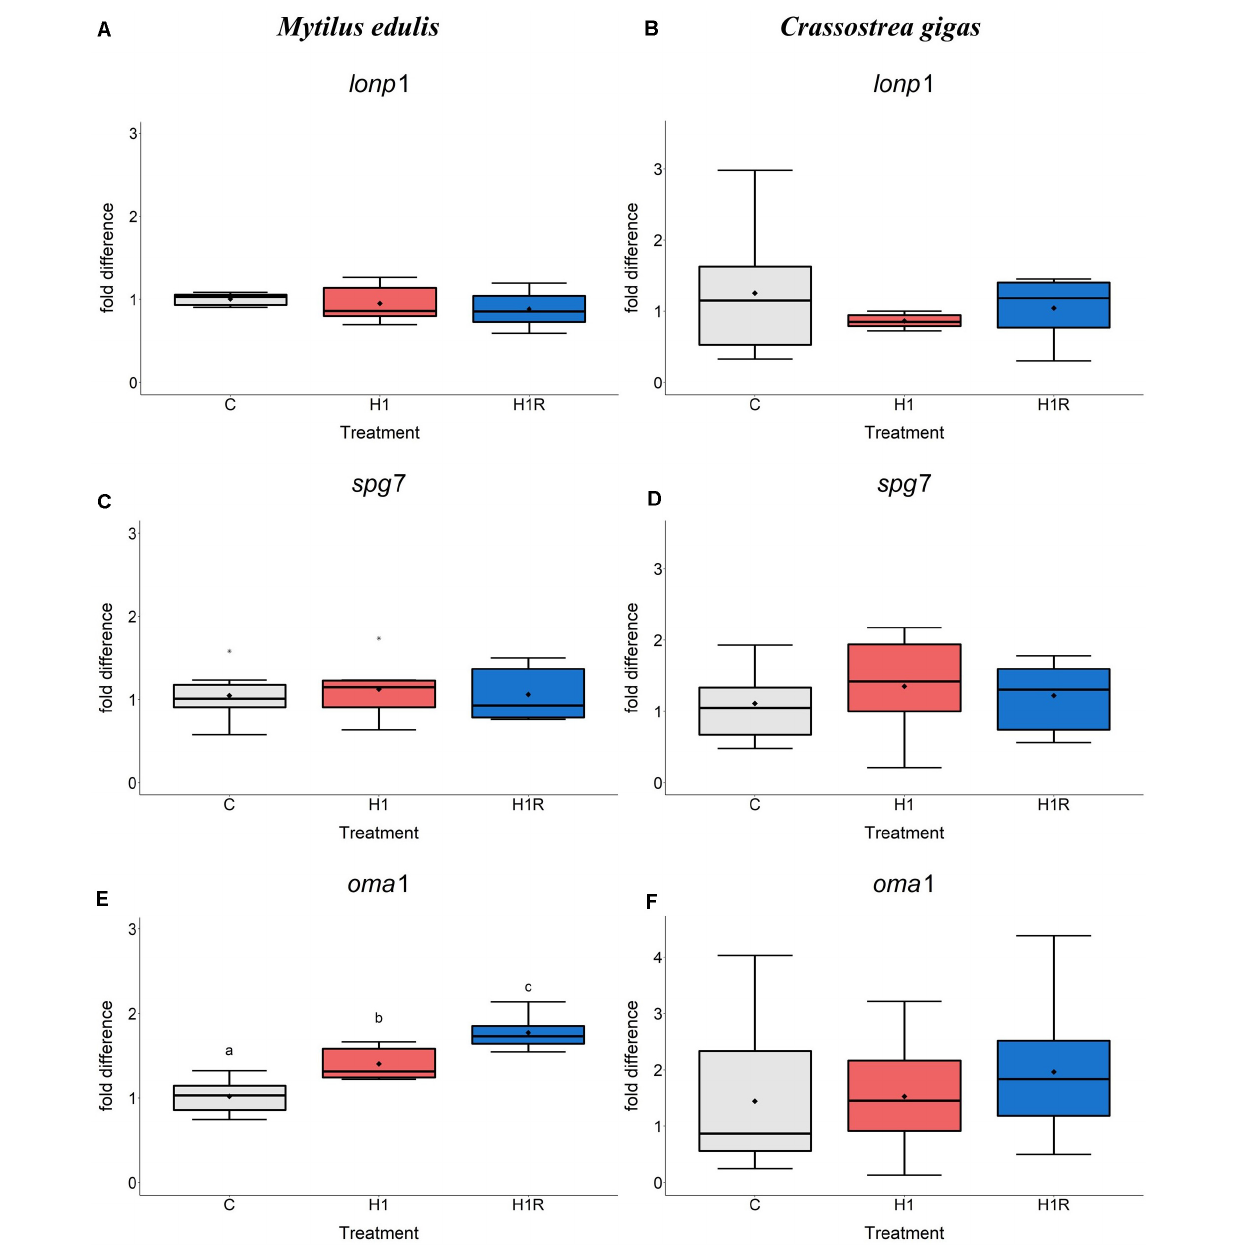
FIGURE 3 | mRNA expression of mitochondrial protein quality control and proteolysis proteins in M. edulis and C. gigas hepatopancreas in response to H/R stress. (A,C,E) M. edulis ; (B,D,F) C. gigas ; (A,B) lonp 1 mRNA; (C,D) spg 7 mRNA, (E,F) oma 1 mRNA. Experimental groups: C, control; H1, short-term (1 day) severe hypoxia; H1R, short-term (1 day) severe hypoxia and subsequent 1.5 h reoxygenation. Means are depicted as points within corresponding Box-Whisker-plot. Outliers are shown as asterisk (*). Different letters above plots represent values that are statistical significantly different from each other ( p < 0.05). Plots sharing a letter are not significantly different ( p > 0.05). N =